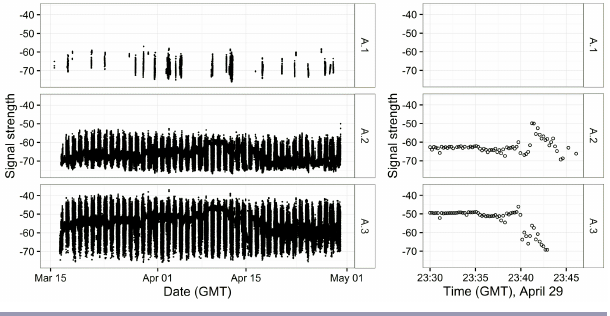
Fig. 3 . Raw signal strength (dB) data for a radio-tagged Swainson’s Thrush ( Catharus ustulatus ) detected on three antennas (A.1, oriented 270°; A.2, oriented 150°; and A.3, oriented 0°) on a Motus station deployed in the Andes, Colombia in 2016 (Figure 4, site A; Gonzalez and Hobson, unpublished data ). After it was tagged on 16 March, this individual remained at the overwintering site until its departure on 29 April 2016. Patterns in signal strength variation during overwintering suggest greater activity levels during the day (higher variation), and reduced activity at night (lower variation; left panels). The right panels show signal strength data immediately before and during departure on 29 April, which shows a period of inactivity followed by departure from the site at approximately 23:40